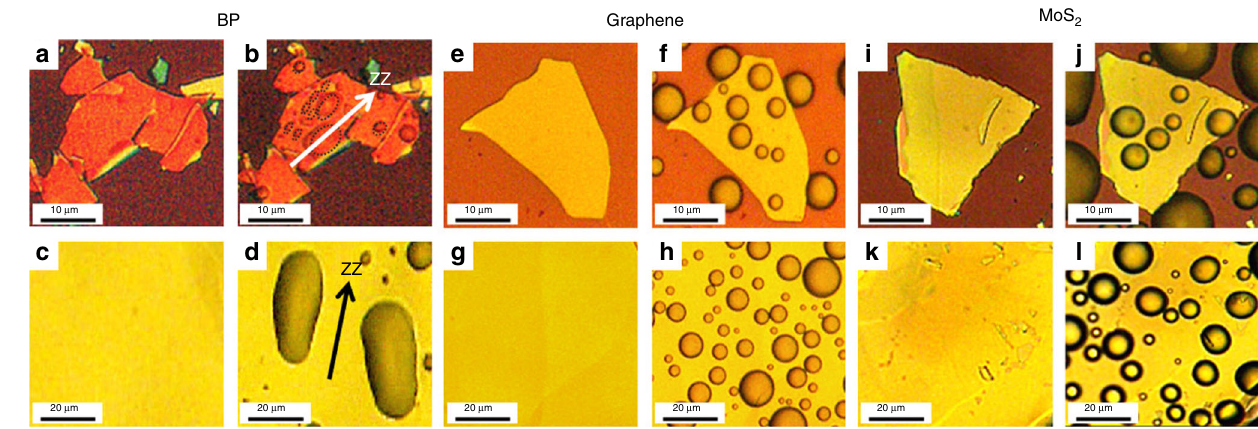
Fig. 1 Optical microscope images of BP/graphene/MoS 2 without and with water droplets. a , e , i Few-layer BP/graphite/MoS 2 without water droplets, b , f , j few-layer BP/graphite/MoS 2 with water droplets, c , g , k thick BP/graphite/MoS 2 without water droplets, and d , h , l thick BP/graphite/MoS 2 with water